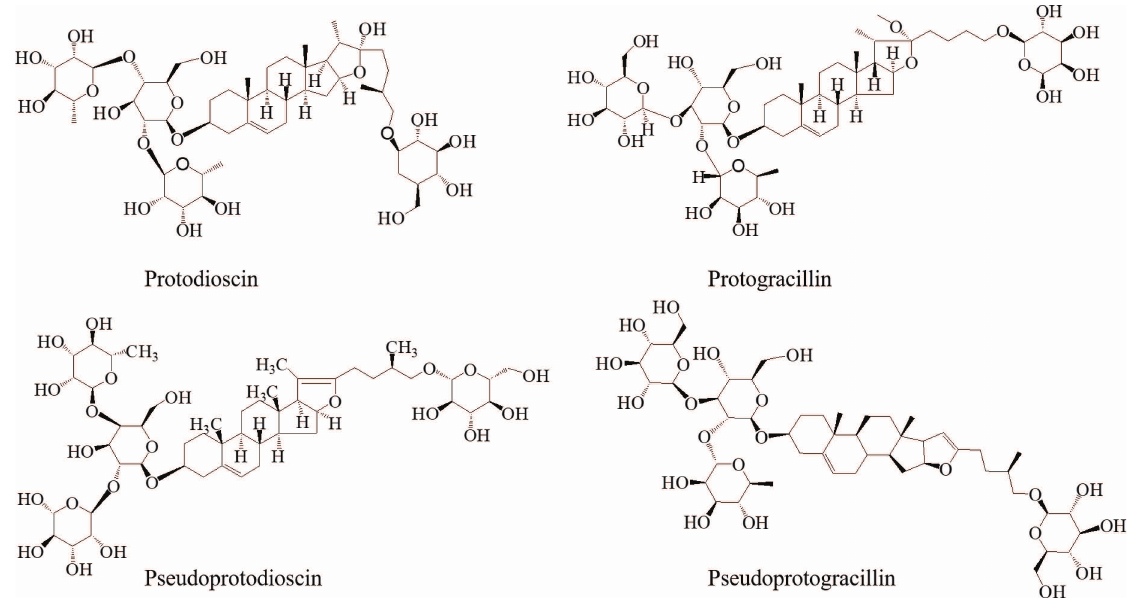
Figure 6. Chemical structures of protodioscin, protogracillin, pseudoprotodioscin, and